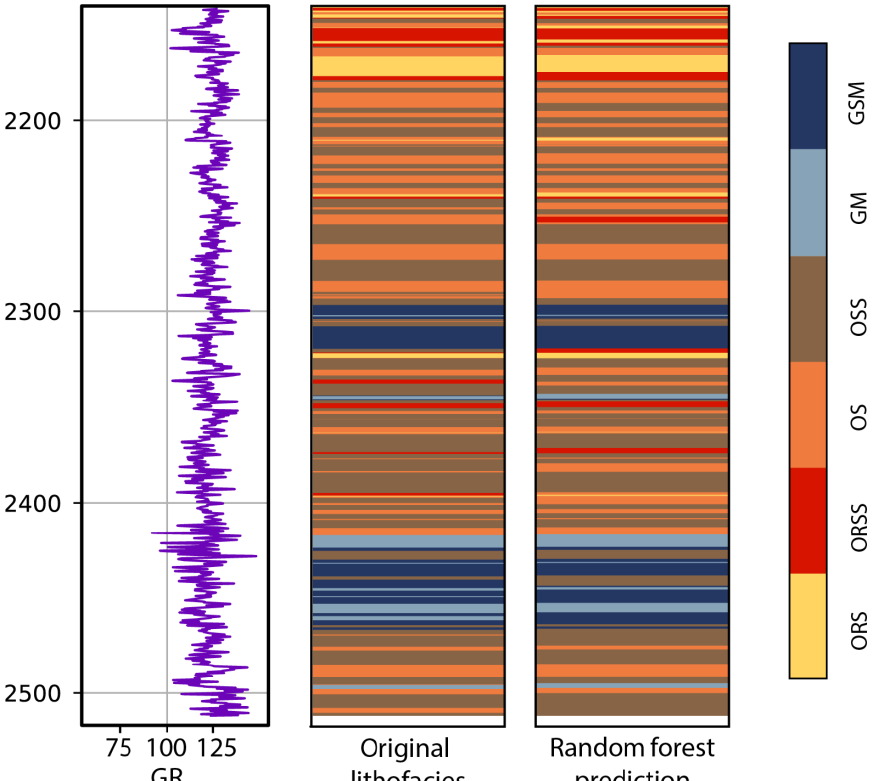
Figure 11. Lithofacies prediction by Random Forest model on a test well in the study area. Refer to the text for abbreviations of lithofacies and well logs. Table 4. Precision, recall, and F1-score of Random forest model on a test well.